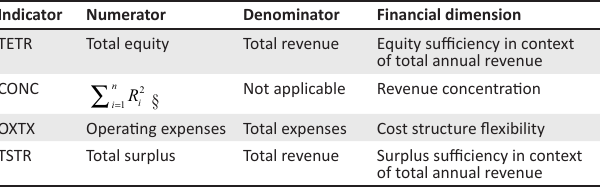
TABLE 1: Tuckman and Chang